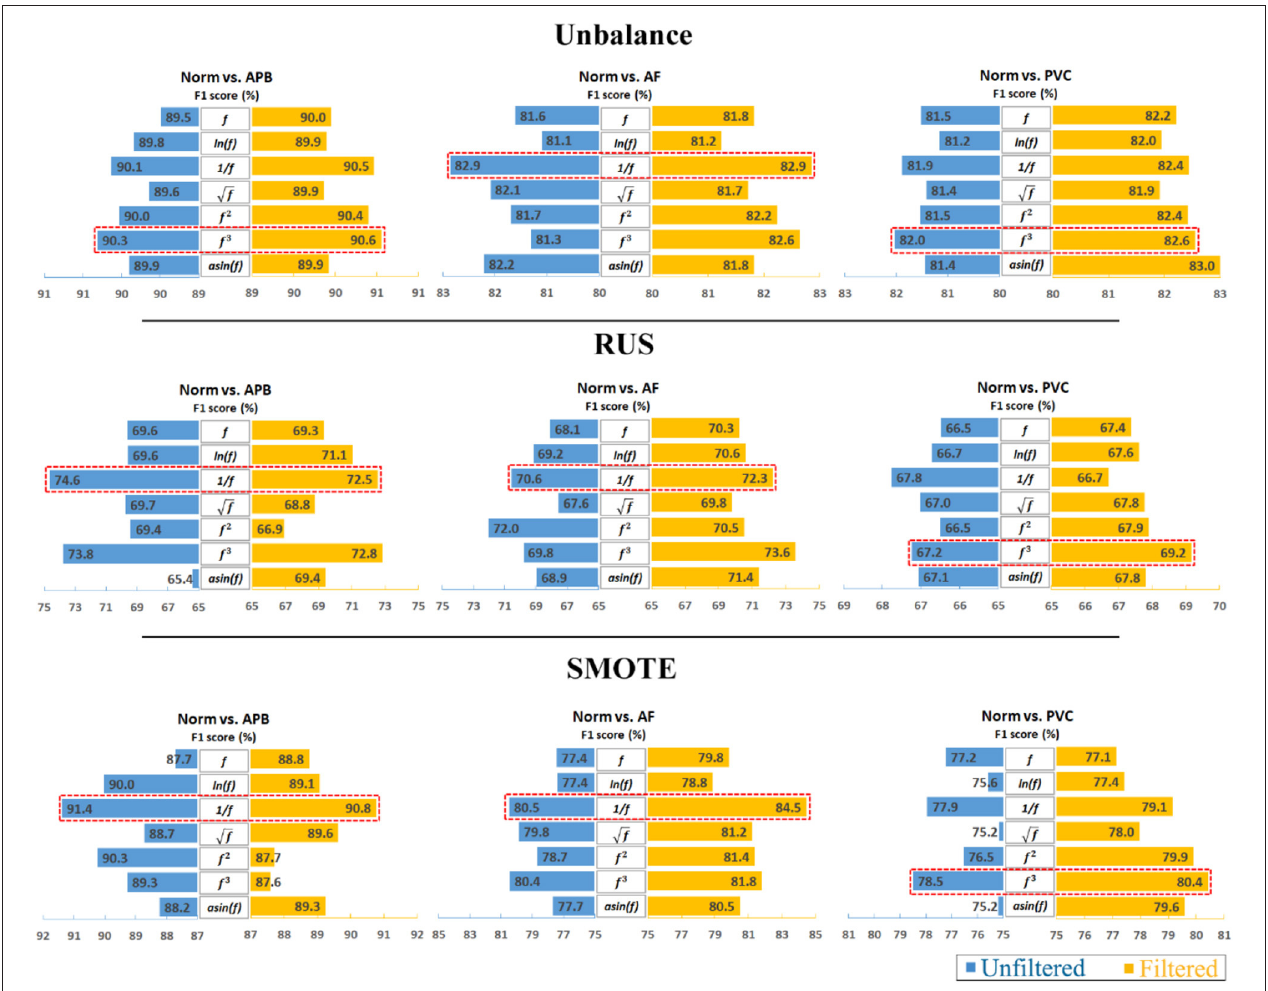
FIGURE 2 | Comparison of classification performance between unfiltered data and filtered data. Note that the reciprocal is the most consistently effective data transformation.